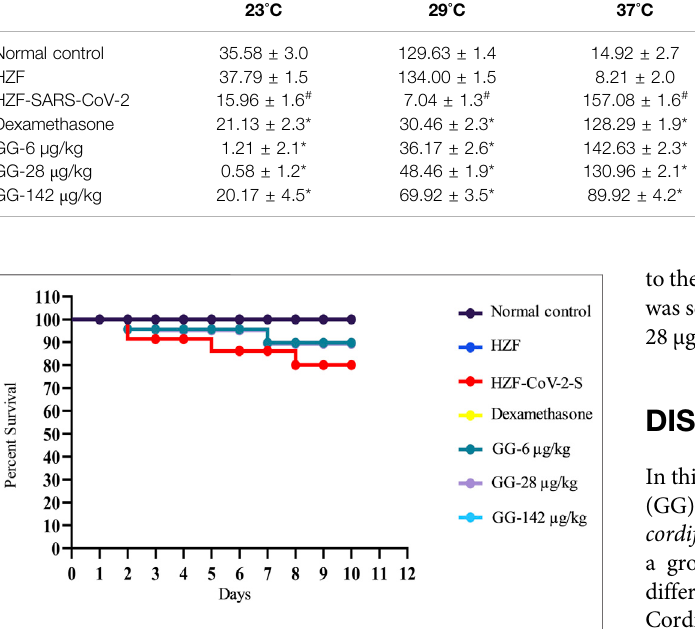
FIGURE 9 | Mortality in the different study groups was recorded every day for 10 days in a parallel experiment. Survival analysis is presented as Kaplan-Meier